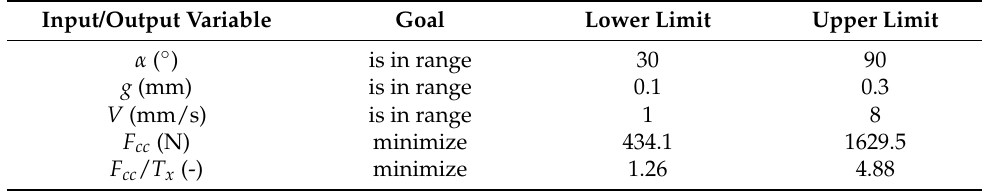
Table 8. Assumed criteria of